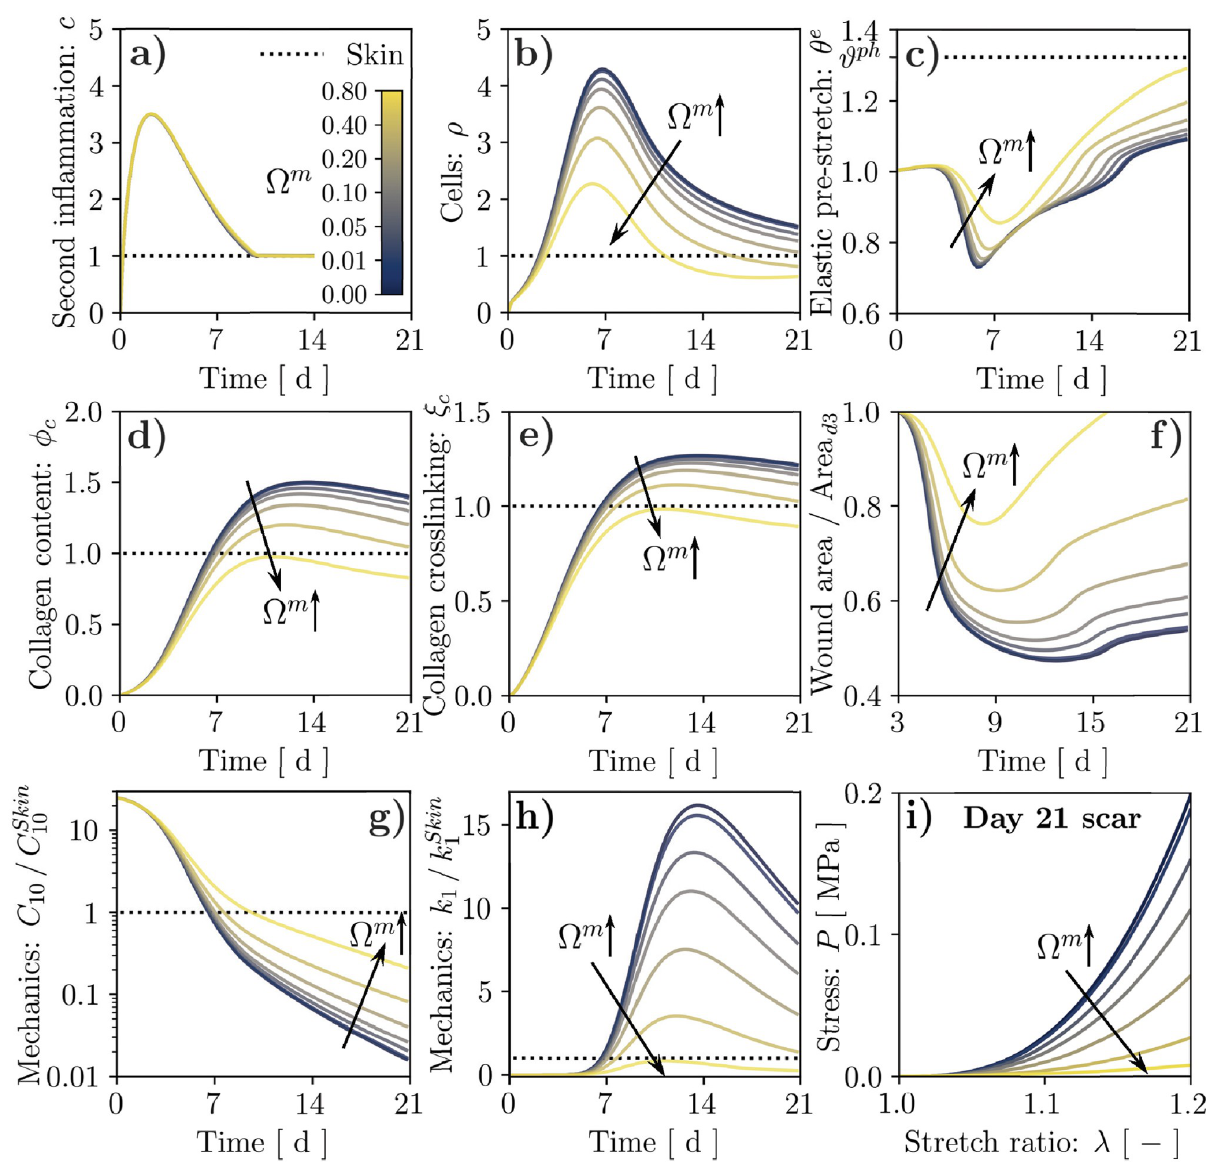
Fig 7. Results of wound healing simulation over a 21-day period for stretch-mediated mechanosensitivity and alternative values of the coupling strength, as controlled by the parameter O m . Temporal evolution of: second inflammatory signal, c , ( a ); cell population, ρ , ( b ); tissue elastic stretch, θ e ( c ); tissue collagen content, ϕ , ( d ); collagen crosslinking, ξ , ( e ); wound area change ( f ); mechanical parameters C c c wound healing outcome in terms of tissue mechanical behavior is visualized by evaluating its tensile response at day 21 post-wounding ( i